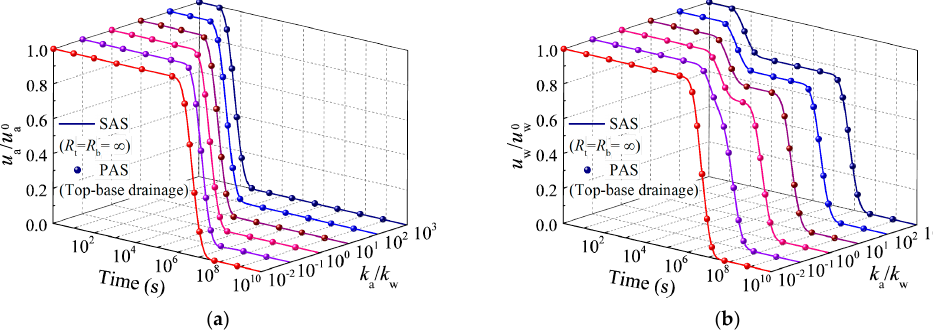
Figure 2. Excess pore-pressures under top-base drainage boundary calculated from semi-analytical solution (SAS) and previous analytical solution (PAS): ( a ) air phase and ( b ) water phase.